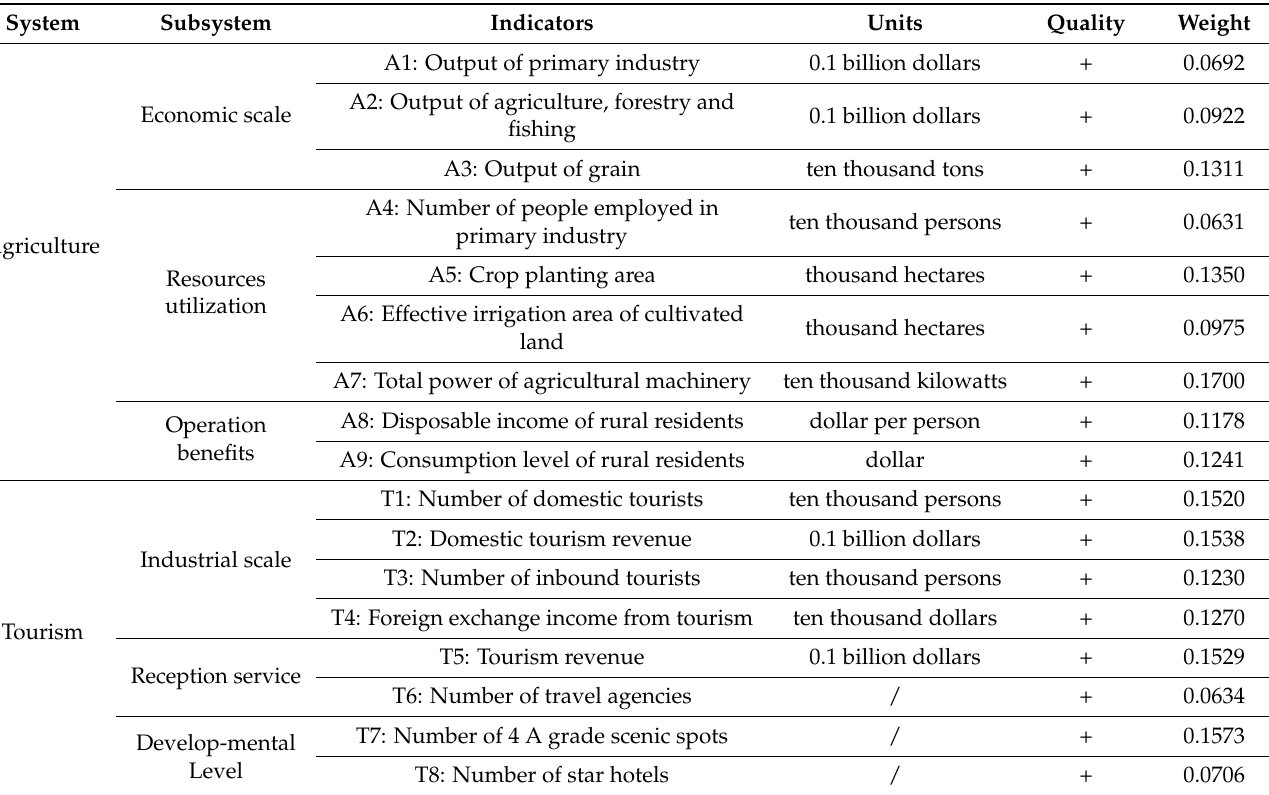
Table 1. Index system and weight of coupling and coordinative system between the agriculture industry and the tourism